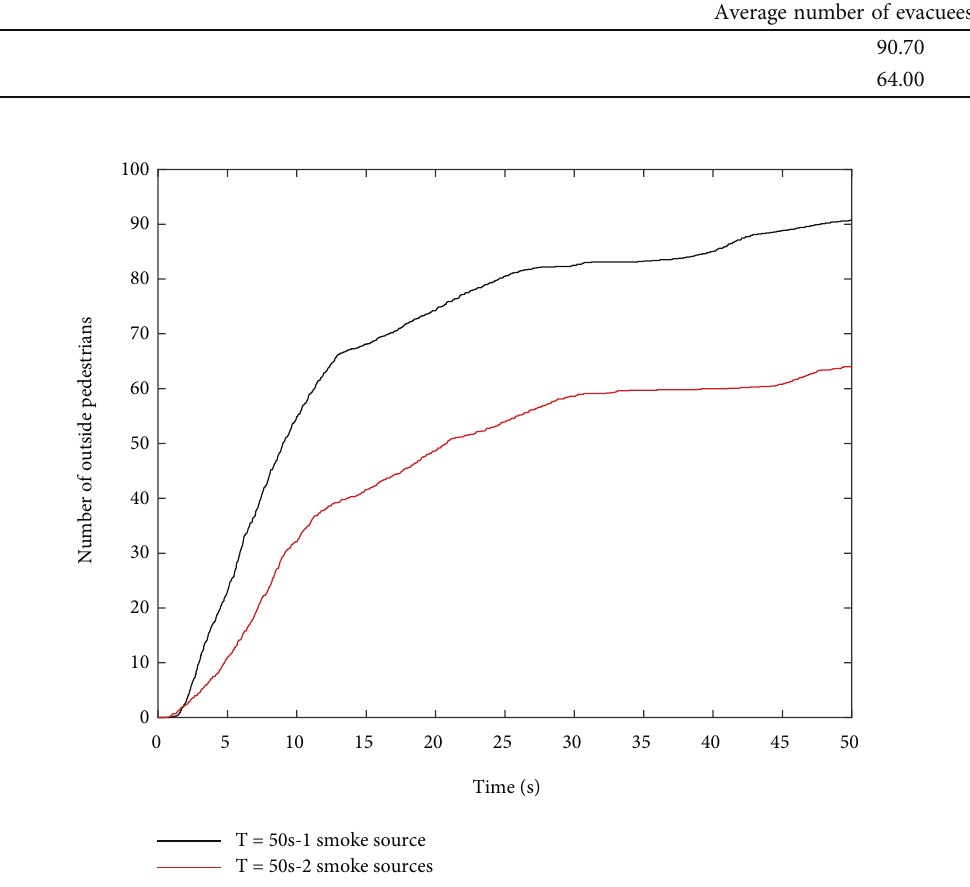
Figure 7: Average number of evacuees of ten trial runs of 100 individuals with 3% guiders in simulations. There are one and two smoke sources. For a source of smoke, it is located in the middle of the room. Two sources of smoke are placed in the middle of the room and in front of exit 1. The simulation domain is a room with two exits as Figure 3(b). The entire time period of a simulation is